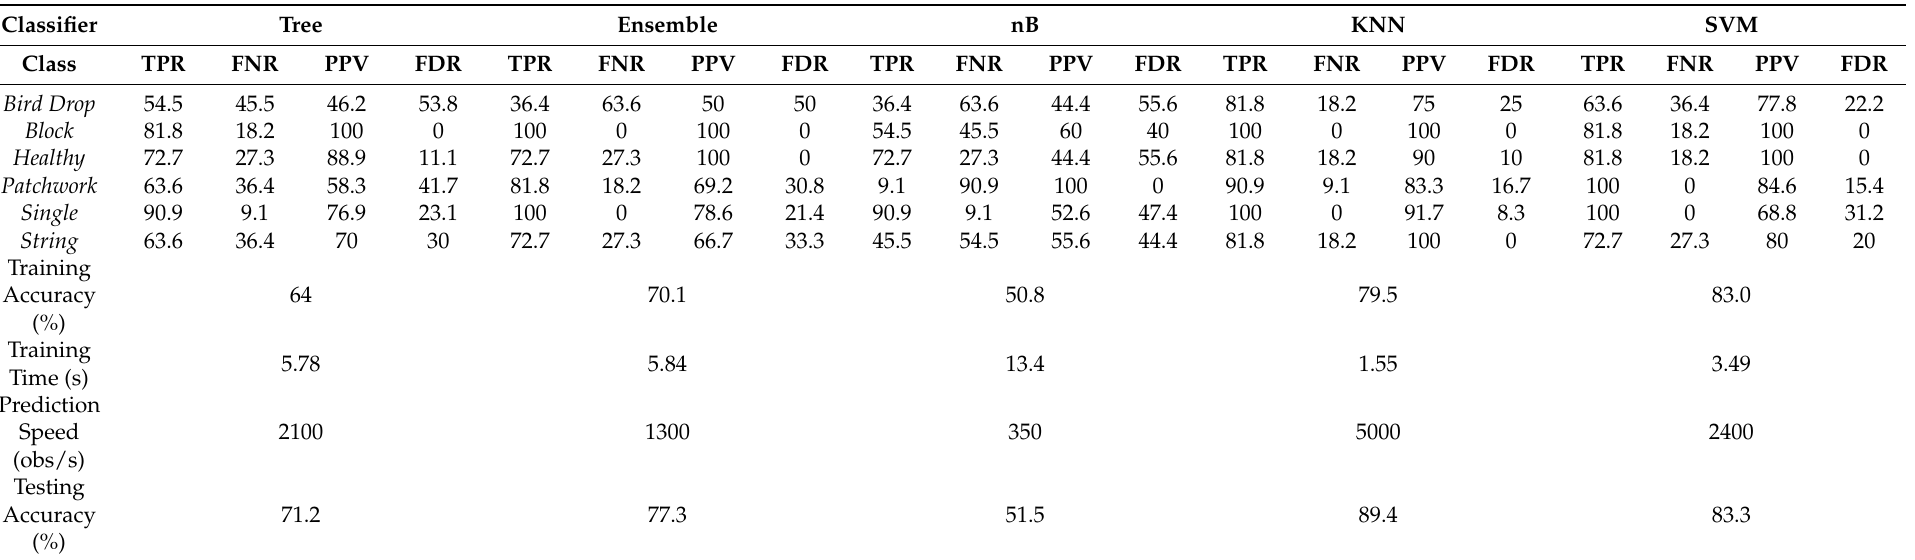
Table 2. Manual features-based shallow